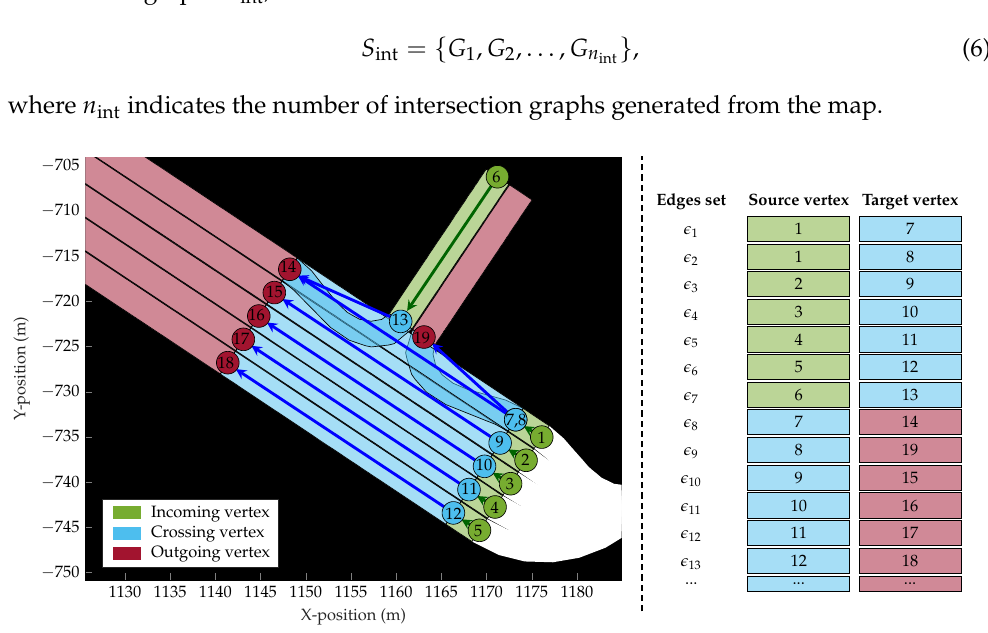
Figure 4. The graphical representation of an intersection. On the ( left ), the vertices are coloured polygons, where the circles represent the first point of the centreLine feature, and the arrows con- necting the circles represent the edges. On the ( right ) are the edge matrix with the edge list and the corresponding vertices. In this case, V ι ,in = 1,2,3,4,5,6 , V ι ,x = 7,8,9,10,11,12,13 , and V ι ,out = 14,15,16,17,18,19